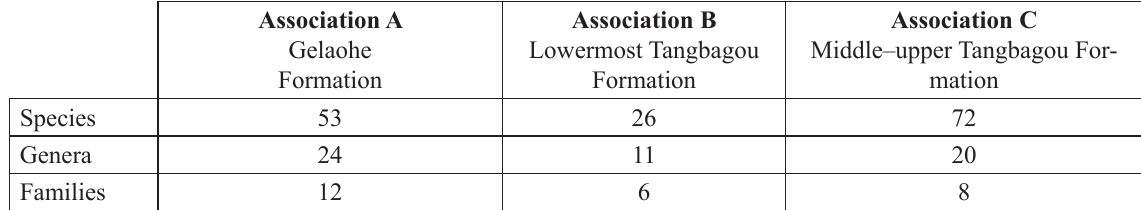
Table 4. Summary of the diversity of each assemblage in the Blue Snake